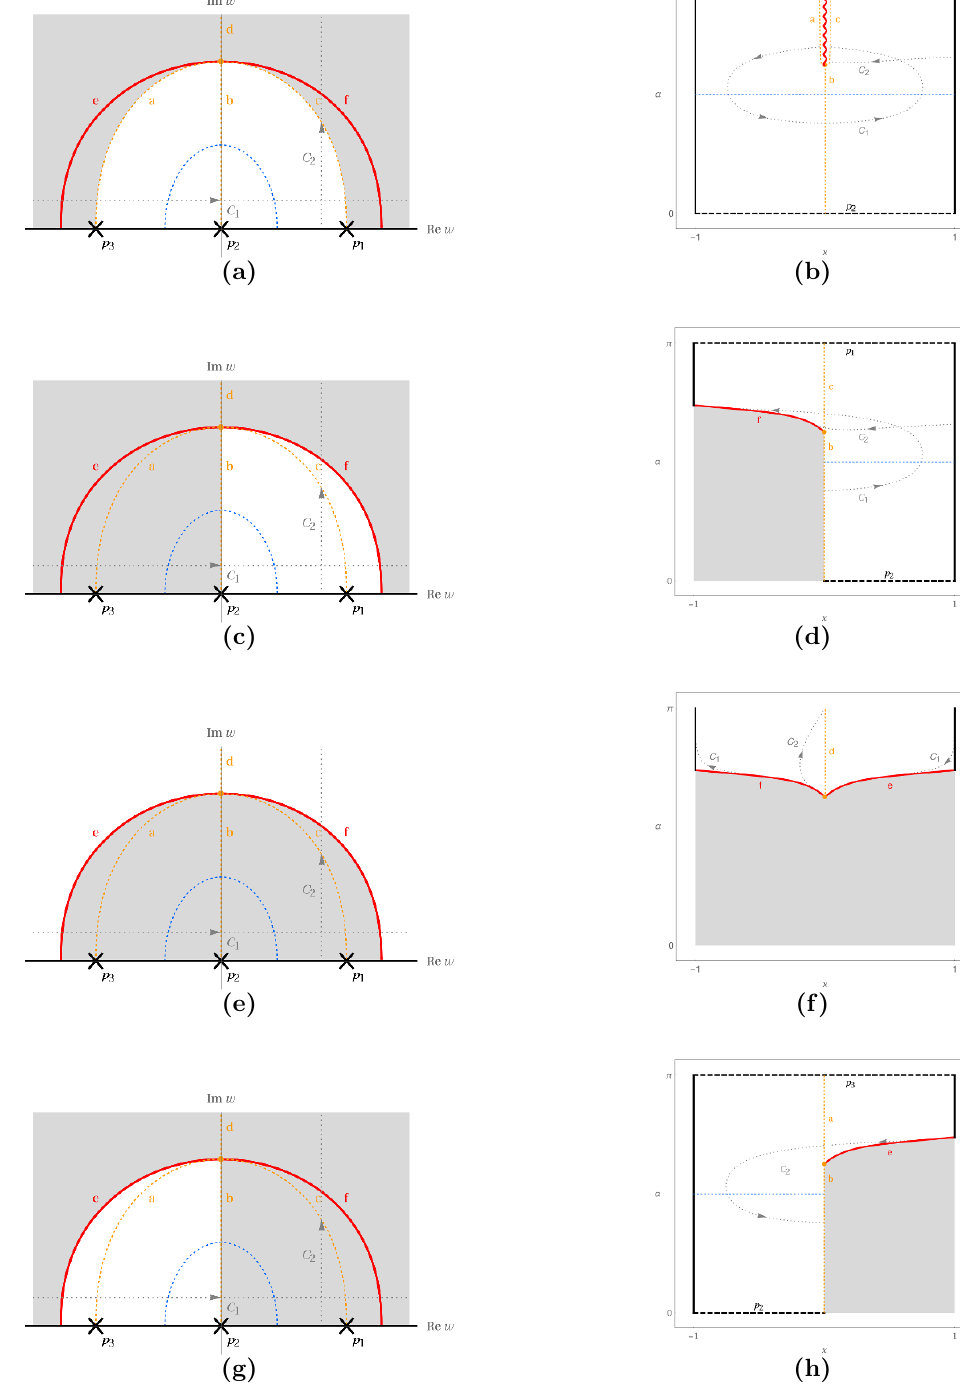
Figure 2. Coordinate patches needed for the 3-pole solution.